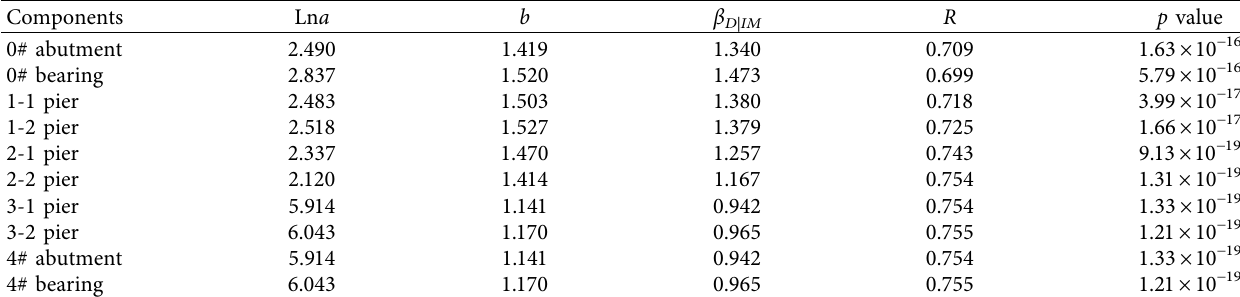
Figure 5: Regression analysis with the results of the time-history analyses for (a) 1-1 pier, (b) 1-2 pier, (c) 2-1 pier, (d) 2-2 pier, (e) 3-1 pier, (f) 3-2 pier, (g) 0# abutment, (h) 4# abutment, (i) 0# bearing, and (j) 4# Table 4: Probabilistic seismic demand models of bridge components.